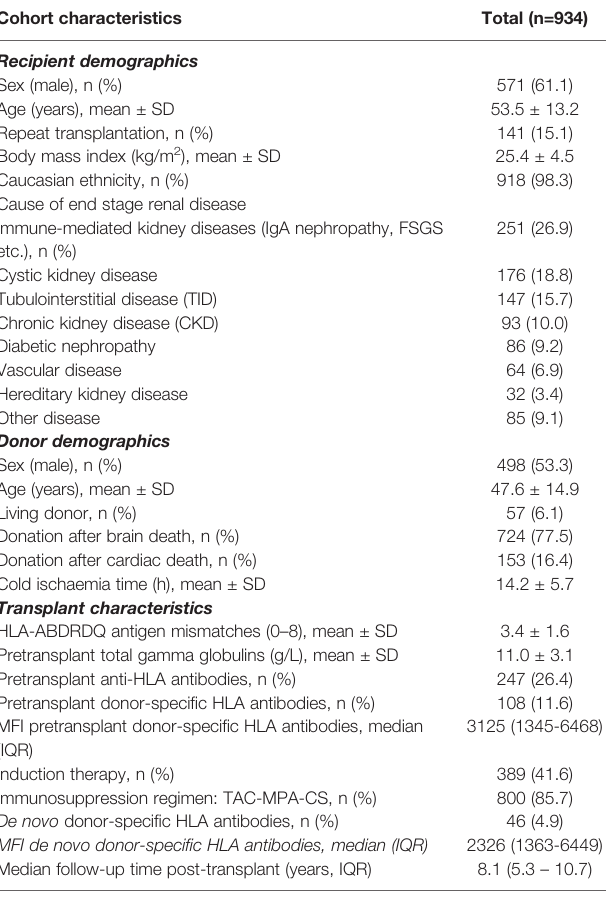
TABLE 1 | Baseline characteristics and follow-up of the study population (n=934).